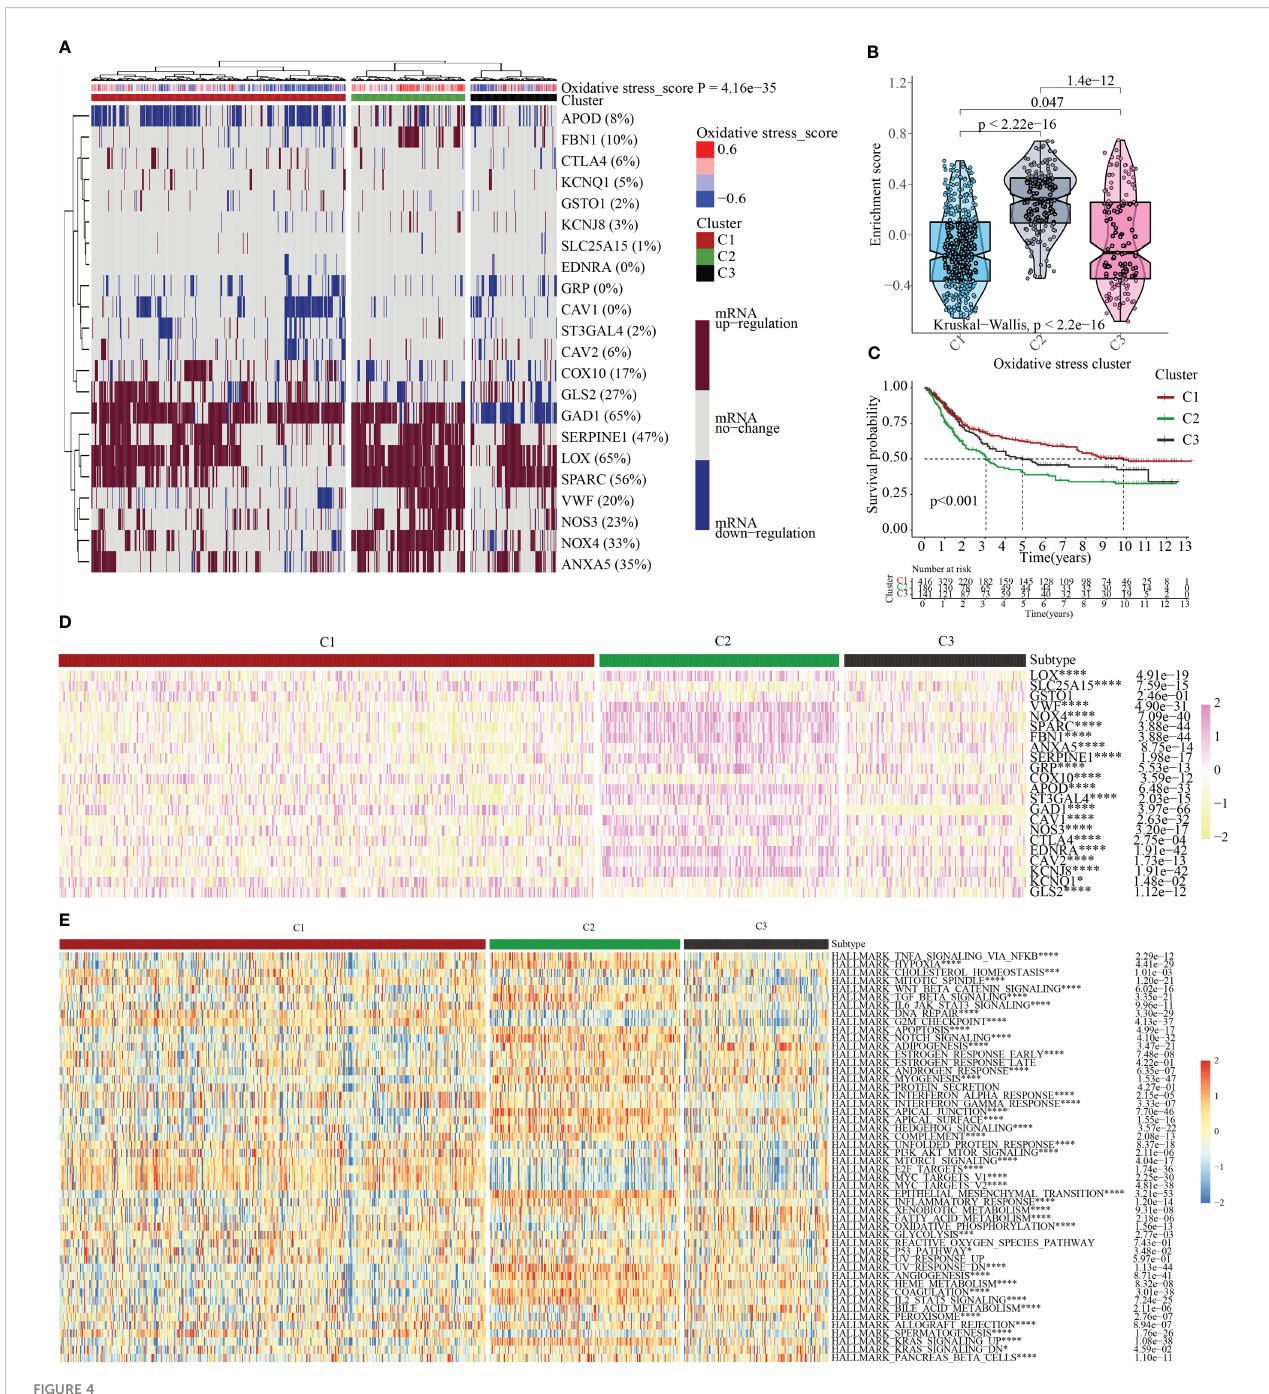
FIGURE 4 Oxidative metabolism scores-based cluster analysis. (A) Heat map cluster analysis of TCGA and GEO gene data illustrating three distinct clusters: inactive oxidative metabolism (cluster 1/C1), active oxidative metabolism (cluster 2/C2), and normal oxidative metabolism (cluster 3/C3). (B) C2 has the highest enrichment score, followed by C3 and C1 in descending order, as observed by the “ ggpubr ” package ’ s violin plot. (C) The survival curve of the three clusters. Years (depicted by the abscissa) are plotted against a survival rate (denoted by the ordinate). (D) The results of differentially expressed OMRGs between three clusters. (E) The relationship between cancer signaling and OMRGs (red color to blue color signi fi es high to low). *P < 0.05; ***P < 0.001; ****P <